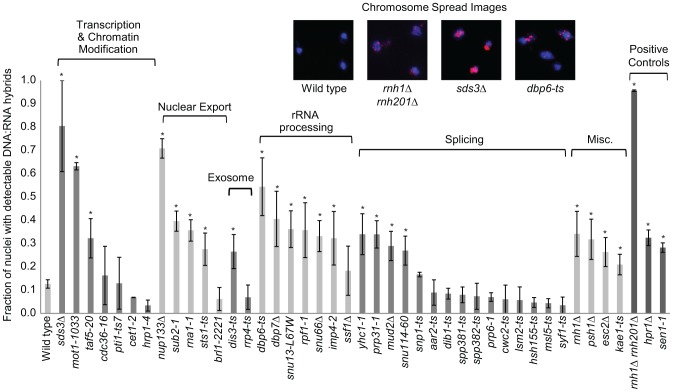
DNA:RNA hybrid cytological screen revealed high DNA:RNA hybrid levels in RNA processing and chromatin modification mutants.Asterisks indicate mutants with significantly increased levels of DNA:RNA hybrids compared to wild type (p<0.00024). Error bars indicate standard error of the mean. Representative chromosome spreads are shown: blue stain is DNA (DAPI) and the red foci are DNA:RNA hybrids.